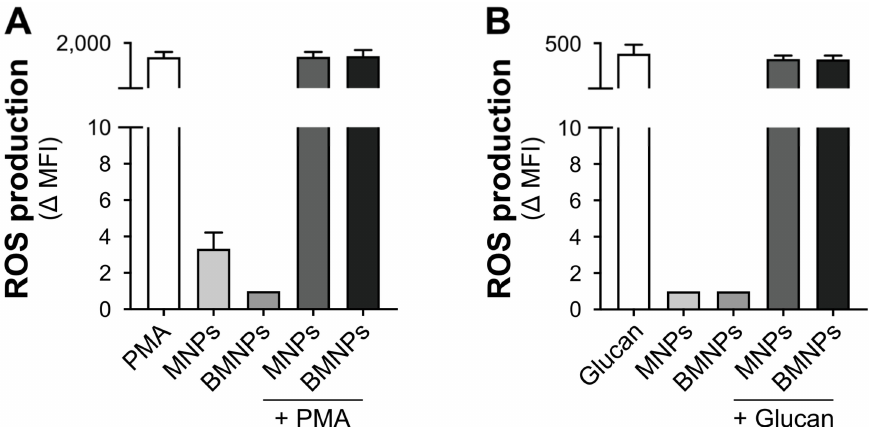
Figure 3. Effects of MNPs and BMNPs on ROS production by human monocytes. Monocytes were labeled with 5 µ M ROS indicator probe CM-H2DCFDA and then treated for 30 min with 5 ng/mL PMA ( A ) or 10 µ g/mL β -glucan ( B ) both in the absence or presence of 300 µ g/mL MNPs or BMNPs, as well as with MNPs or BMNPs alone. ROS production was estimated by flow cytometry. Graphs show ROS production as ∆ MFI values of CM-H2DCFDA probe. The values are expressed as the mean value + SEM of four independent experiments. Statistical analysis was performed by Friedman or Kruskal–Wallis test followed by Dunn’s multiple comparison